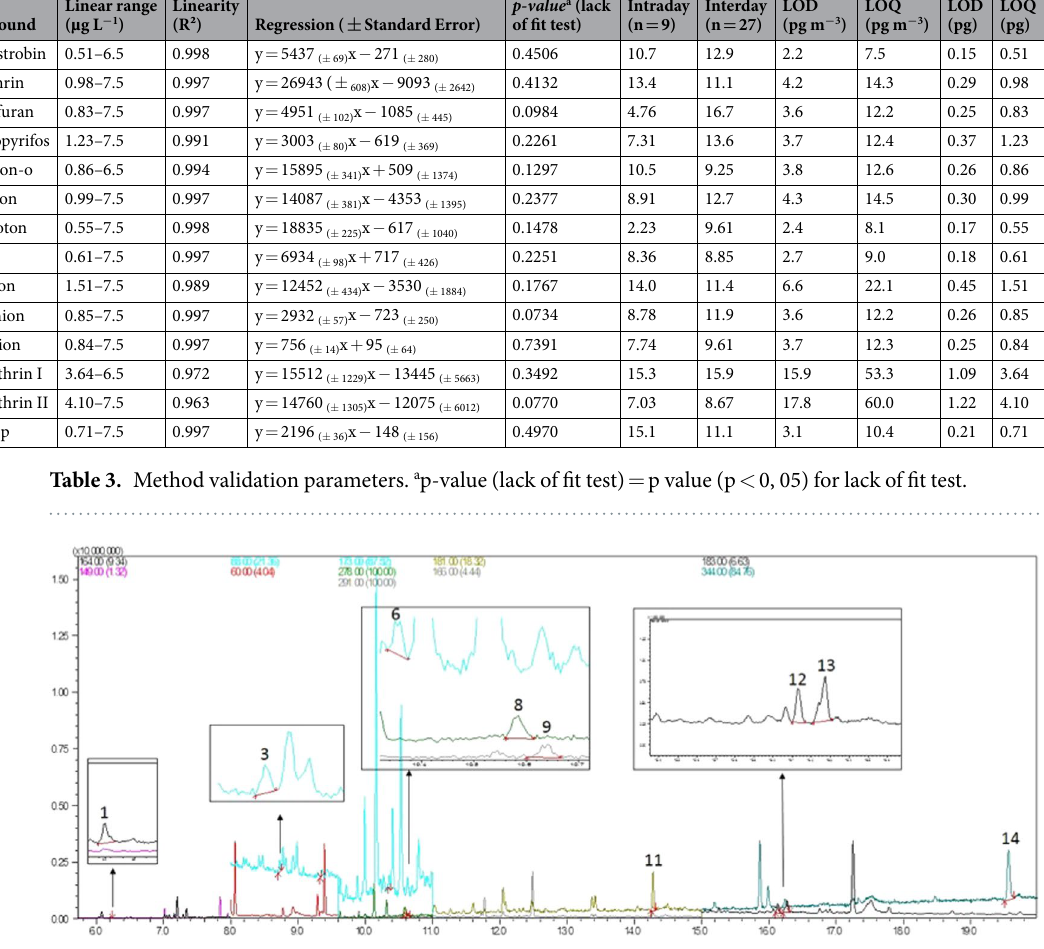
Figure 2. Chromatogram of a real PM2.5 sample collected in the Naval Base site. The following pesticides were detected: [1] Carbofuran (6.20 min), [3] demeton-O (8.73 min), [6] malathion (10.36 min), [8]